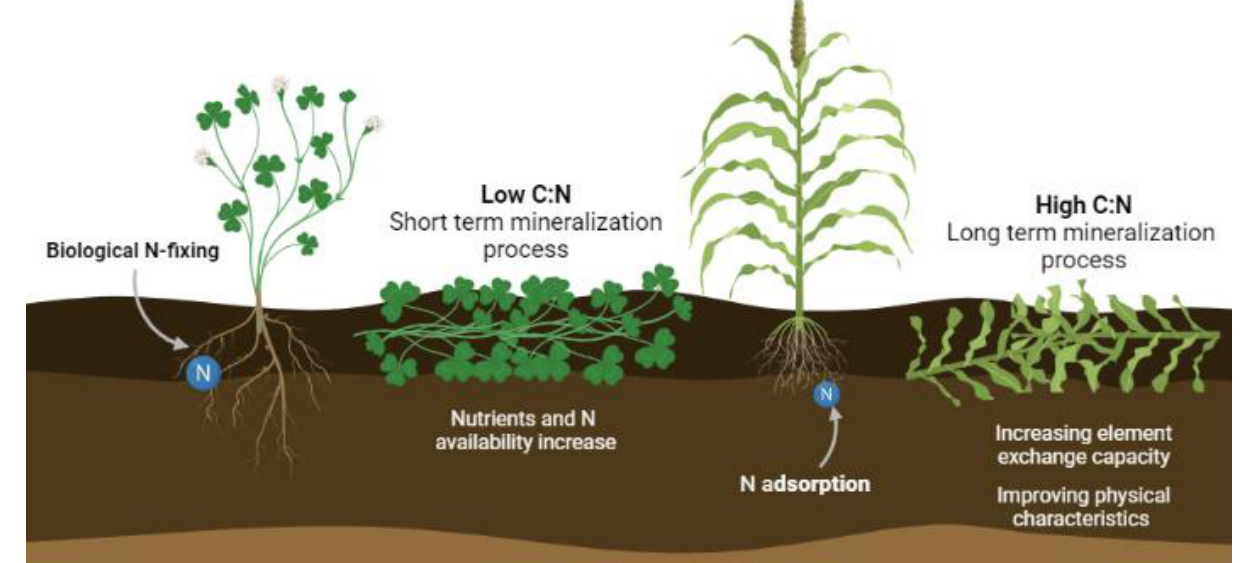
Figure 5. Role of cover crops and their residues on nitrogen cycling in the agroecosystem. Table 2. Benefits of cropping systems achieved through the use of cover crops. Cropping Systems